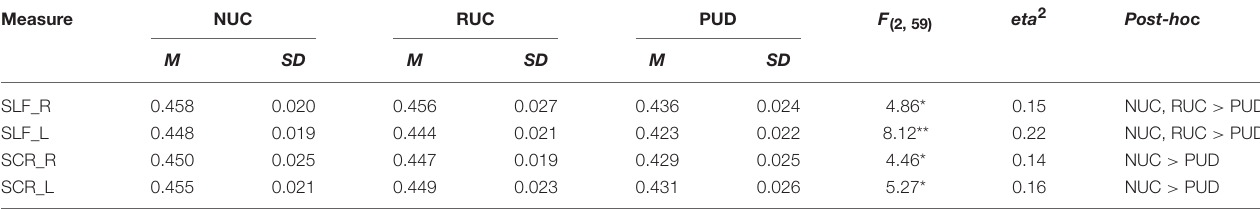
TABLE 4 | Group differences in FA in Regions-of-Interest (ROI). Measure